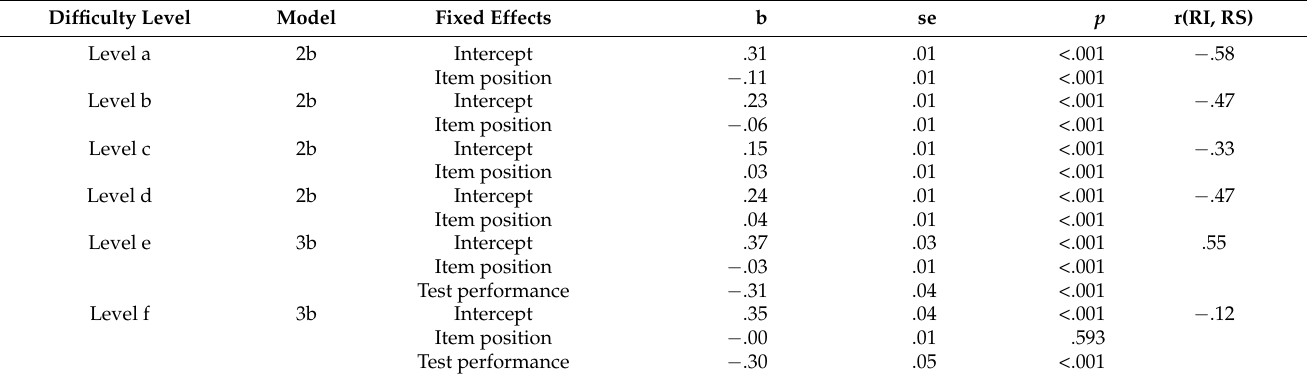
Table 6. Fixed effects and correlations between random intercept (RI) and random slope (RS) of the MLM with the dependent variable relative number of fixations on the left cube.